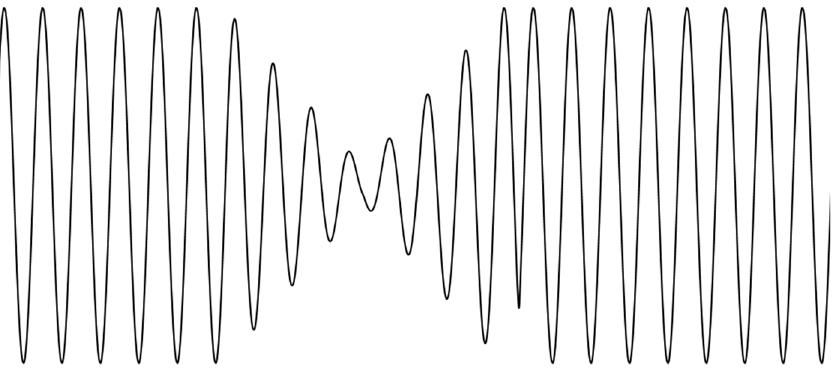
Figure 6. An example of amplitude modulation caused by changes in loading. Note that the width of the dip is greatly exaggerated for clarity.